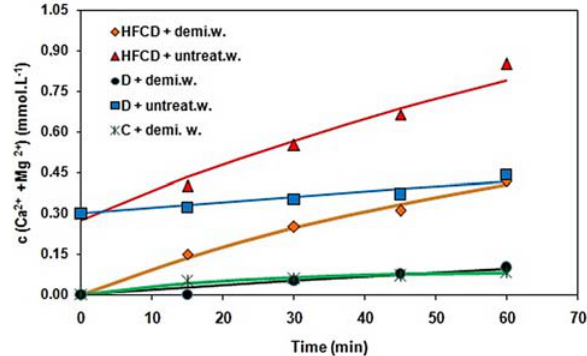
Figure 2. Time dependencies of (Ca 2+ + Mg 2+ ) content using diffe- rent recarbonization agents–experimental values (points) and cal- culated values (lines).